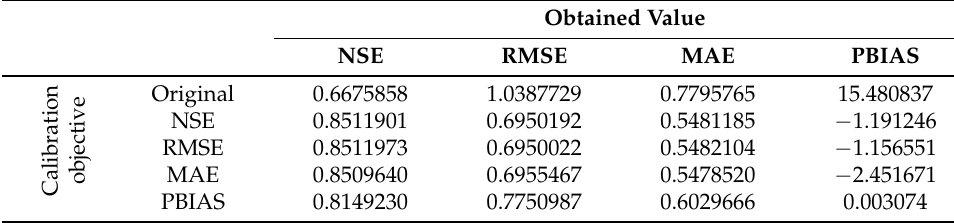
Table 3. The comparison of statistical measures before and after the calibration process of the Kharrufa equation. The first row represents the values of various statistical measures (see columns) of the original model. Remaining rows determine the objective statistical measure, which respect to the model was calibrated. The columns represent the corresponding values of various measures.